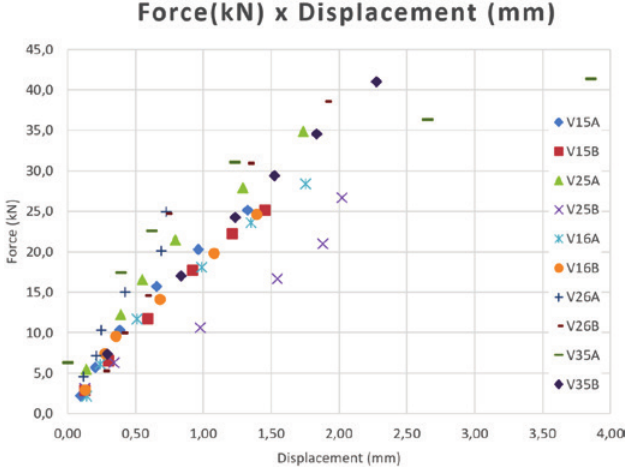
Results of the ten beams testing - Force (kN) x Displacement (mm)